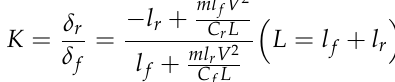
Figure 14. Standard H2/H∞ design problem of the 4WS vehicle .